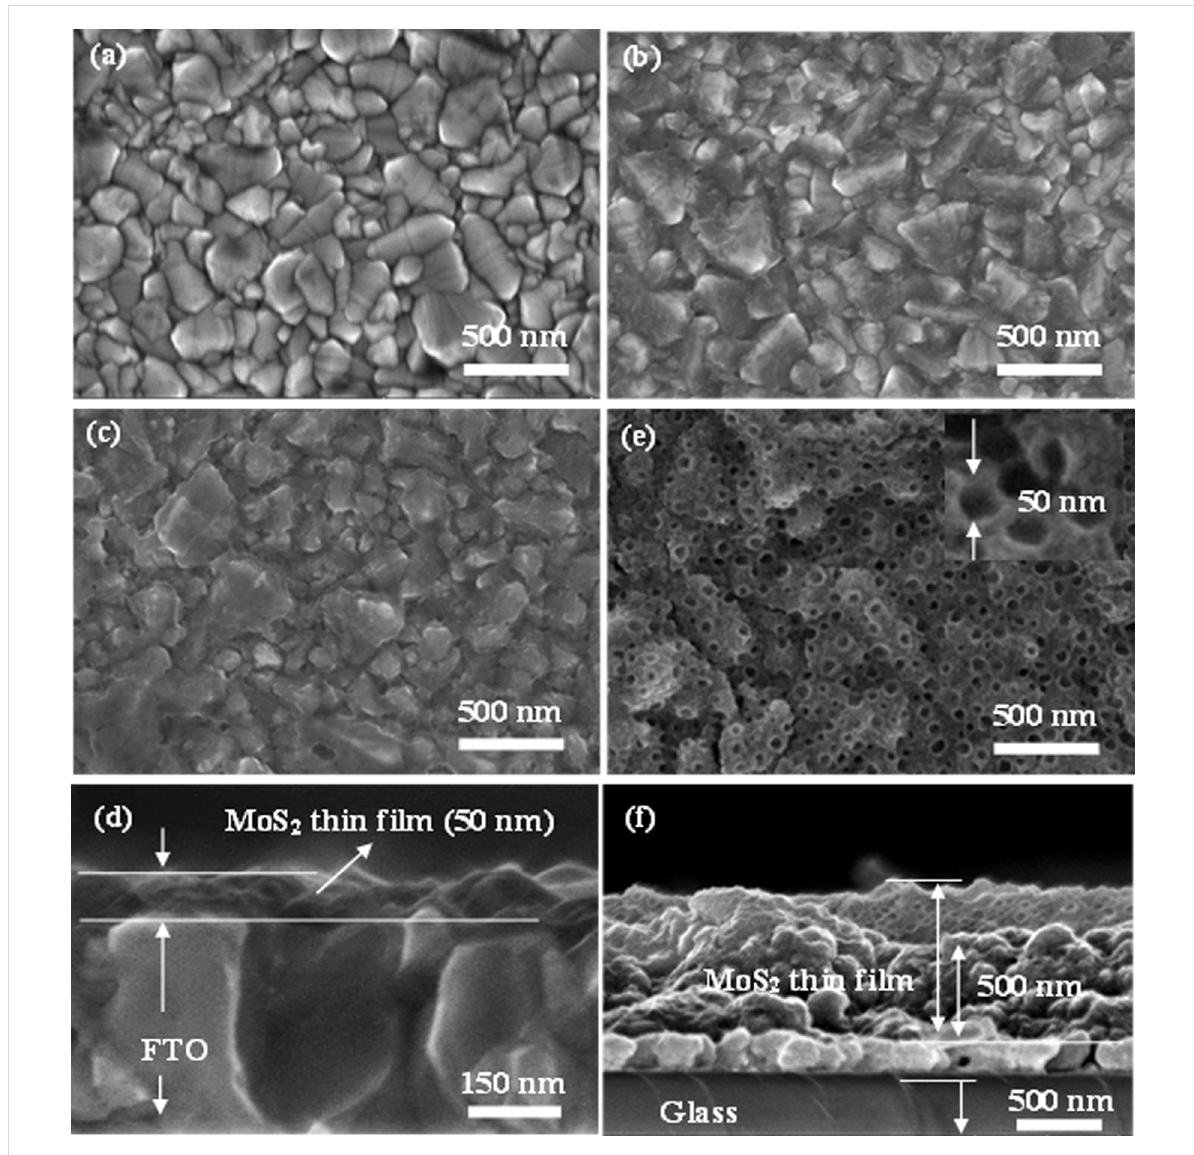
Figure 3: FE-SEM images (top view and cross-sectional view) of (a) FTO and (b–f) MoS 2 deposited on FTO from different precursor solution concen- trations: (b) solution 1.25, (c ,d) solution 2.5, and (e, f) solution 5.0.